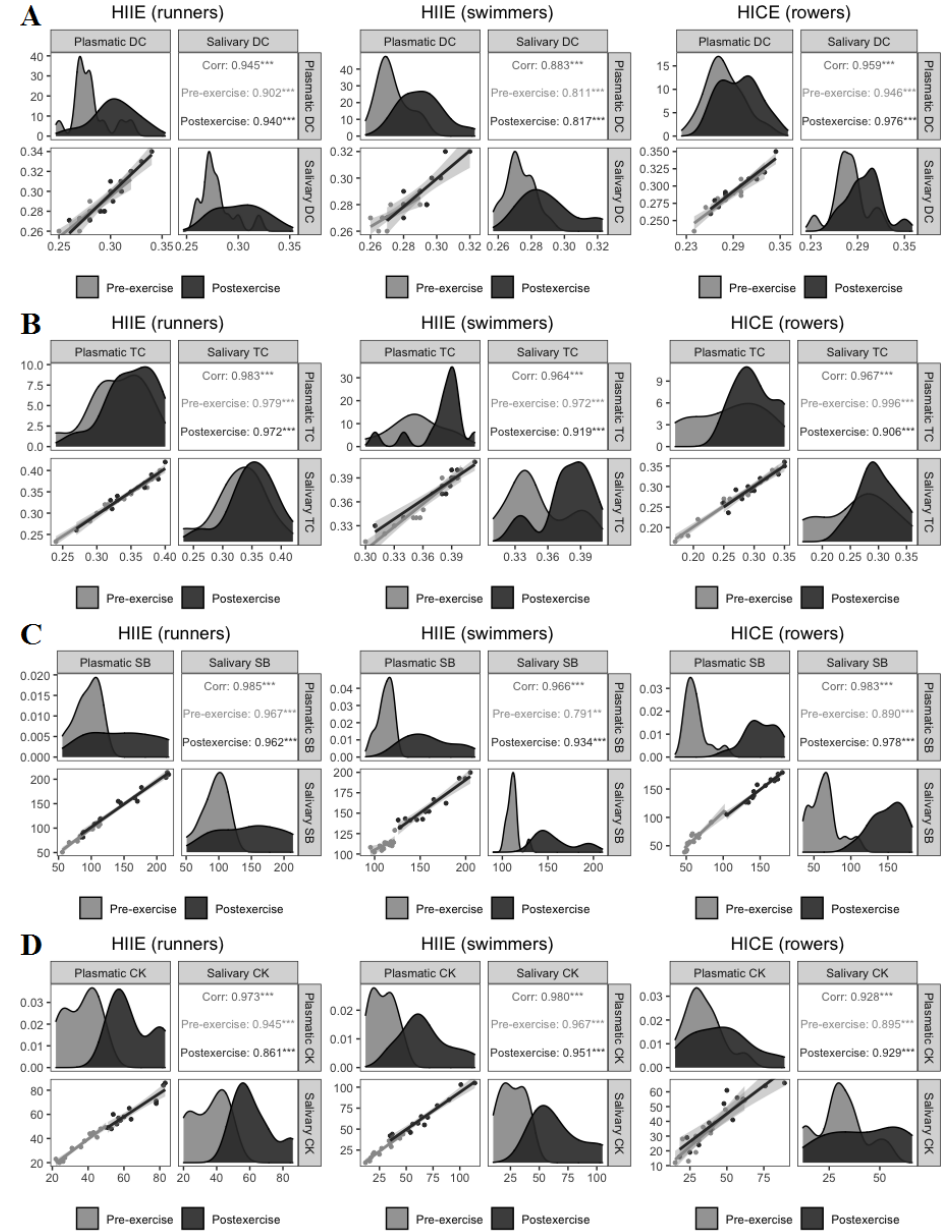
Figure 2. Generalized pairs plots, including density plot, scatter plot and correlation matrix, for displaying distribution and relationship between plasmatic and salivary concentrations of DC ( A ), TC ( B ), SB ( C ), and CK ( D ). n = 13 per group. ** p < 0.01. *** p < 0.001. Corr: Spearman’s correlation coefficient for both pre-exercise and postexercise; Pre-exercise: Spearman’s correlation coefficient at pre-exercise; Postexercise: Spearman’s correlation coefficient at postexercise; DC: diene conjugates; TC: triene conjugates; SB: Schiff bases; CK: creatine kinase; HIIE: high-intensity interval exercise; HICE: high-intensity continuous exercise.